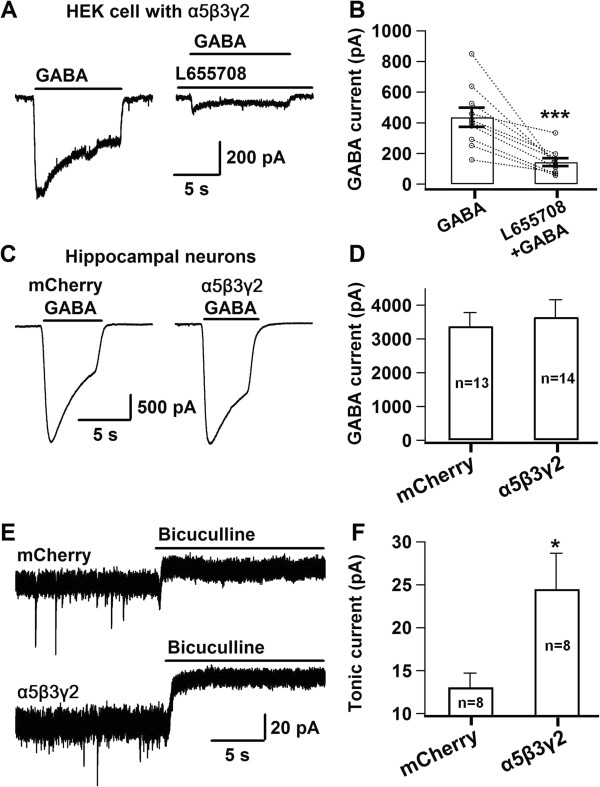
Tonic GABA current increased after the overexpression of α5β3γ2 GABAA receptors. A, Typical GABA (100 μM) induced currents in HEK293T cells transfected with α5β3γ2 subunits (left panel), which could be largely blocked by α5 subunit-specific inverse agonist L655,708 (100 nM, right panel). B, Summarized data showing GABA-induced α5β3γ2 receptor currents in HEK293T cells significantly inhibited by L655,708 (Control, 437.1 ± 63.1 pA, n = 10; L655,708, 142.8 ± 25.7 pA, n = 10; ***, p < 0.001). C, Typical GABA current traces in cultured hippocampal neurons transfected with mCherry or plus the α5β3γ2 subunits. D, Bar graphs showing no significant difference between the total whole-cell GABA currents in neurons transfected with mCherry or plus the α5β3γ2 subunits. E, Representative tonic GABA currents revealed by rapid application of GABAA-R blocker bicuculline (100 μM) in hippocampal neurons transfected with mCherry or plus the α5β3γ2 subunits. F, Summarized data showing that tonic GABA current in α5β3γ2-transfected neurons (24.5 ± 4.2 pA, n = 8) was significantly increased in comparison with the control neurons (13.1 ± 1.7 pA, n = 8; *, p < 0.05).